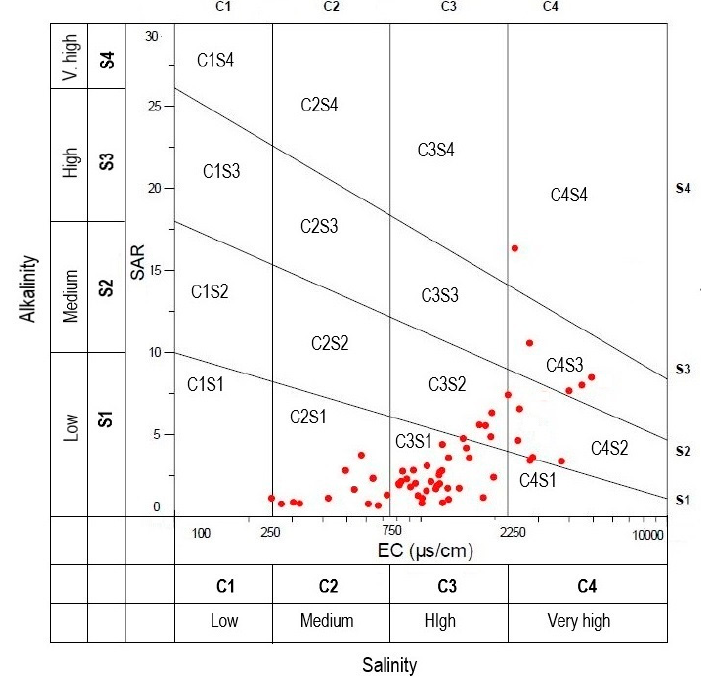
Figure 10. United States Salinity Laboratory (USSL) diagram for irrigation water classification (USSL 1954).